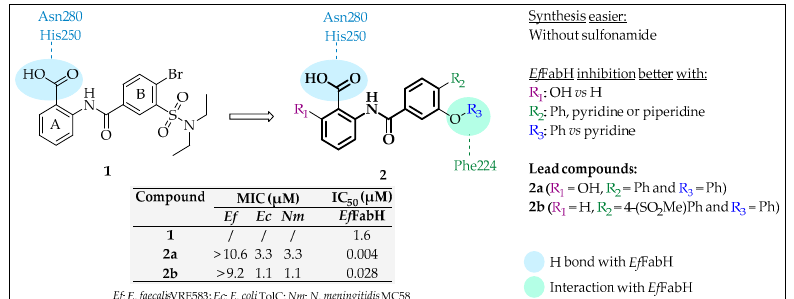
Figure 7. Structures, SAR and representation of main interactions with Ef FabH of benzoylamino- benzoic acids 1 and 2 and in vitro activities of lead compounds [70].